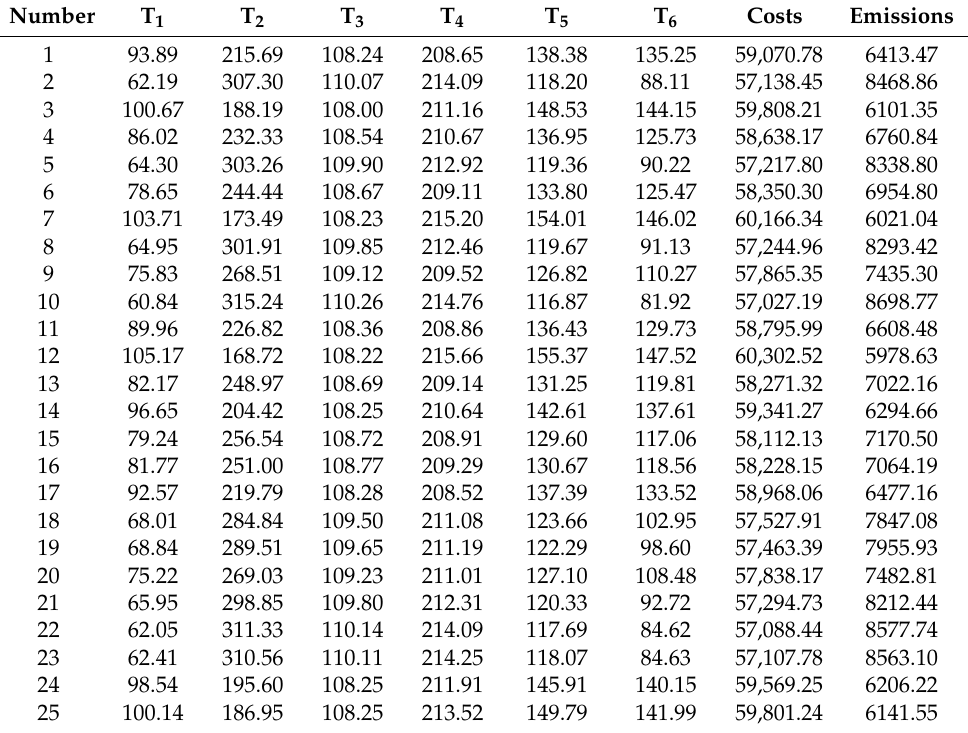
Table 4. Scheduled generation (MW), respective (total) cost ($) and carbon emissions (lb) ( α =